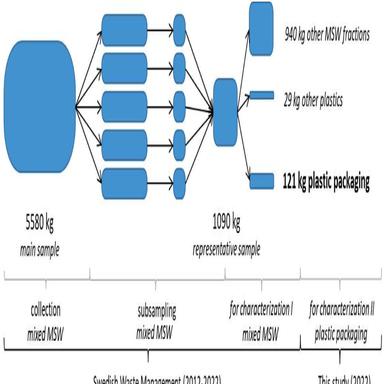
Illustration of the subsampling procedure following the annual sampling program of mixed MSW in the case city (2012–2022). The component plastic packaging was sorted and subjected to an extended characterization for the purpose of this study (2022). Note: The values (in kg) are on a wet-weight basis.